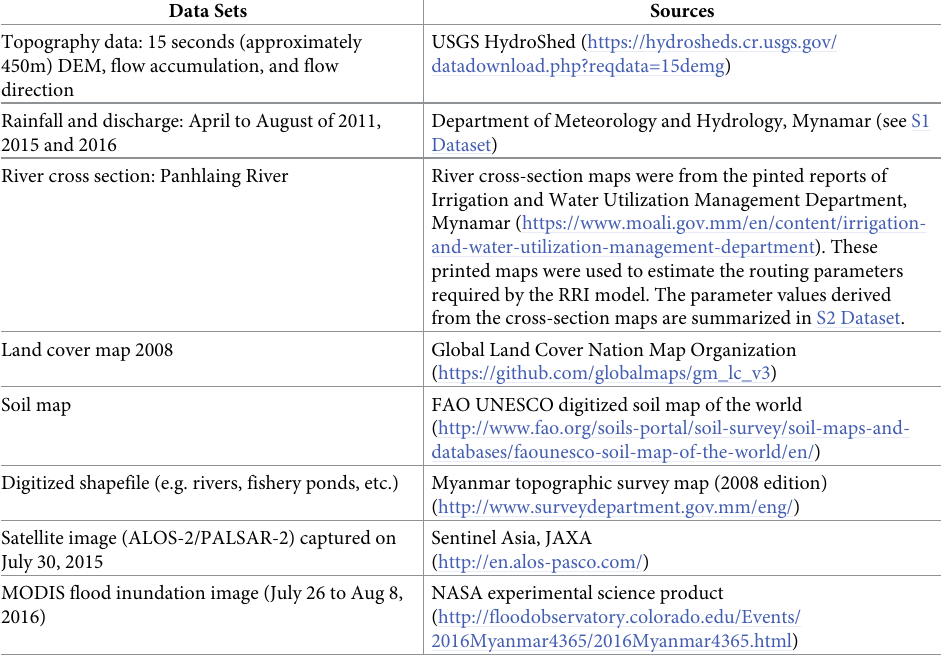
Table 1. Data sets and data